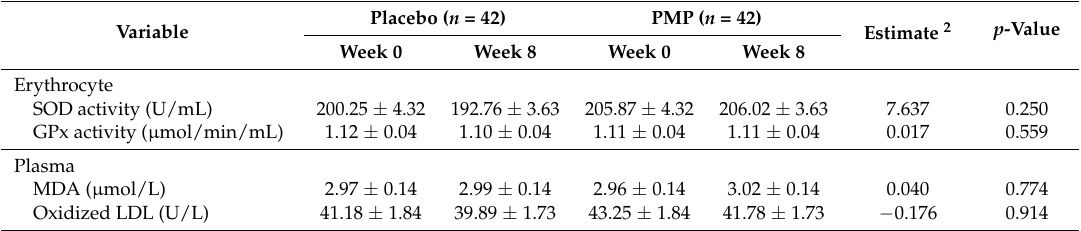
Table 2. The effect of placebo and PMP supplementation on lipid oxidation and endogenous antioxidant defense 1 .